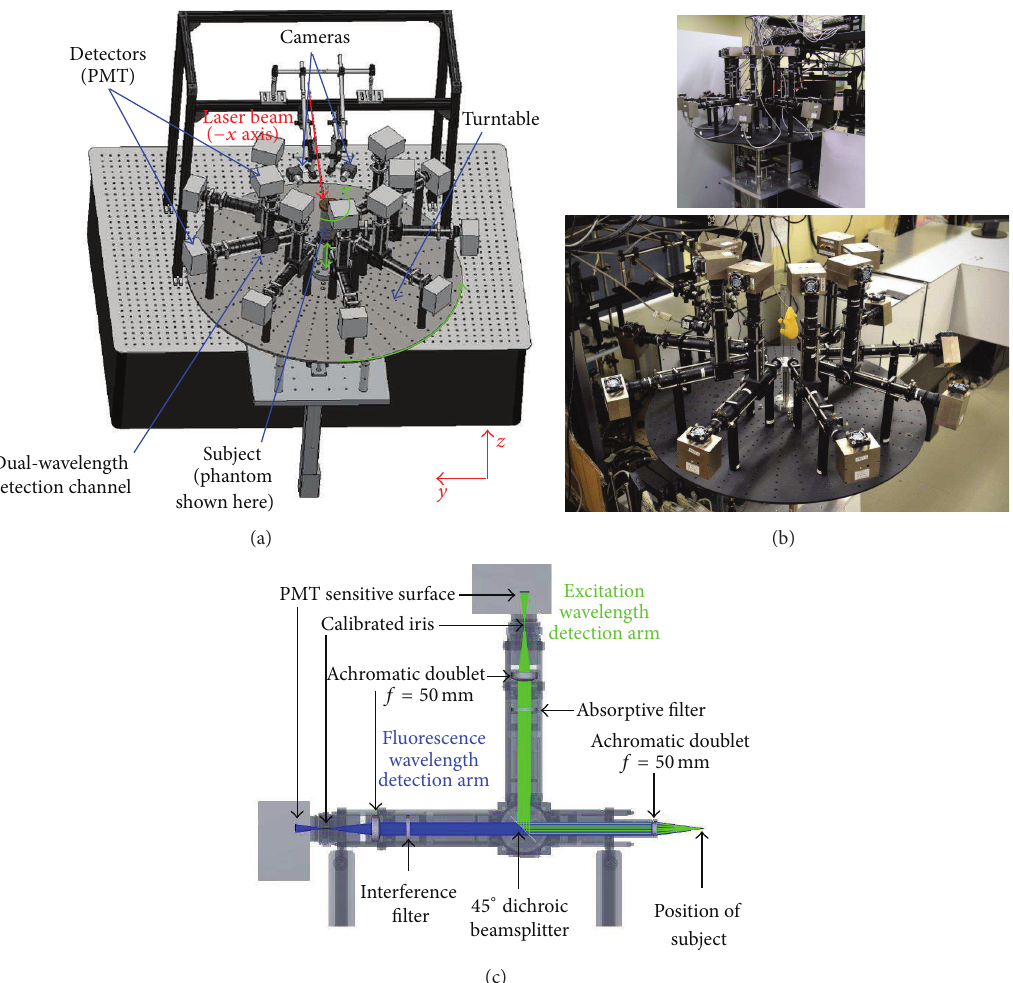
Figure 6: Drawing and photographs of the first-generation TomOptUS scanner (a, b); drawing of one dual-wavelength detection channel (c).